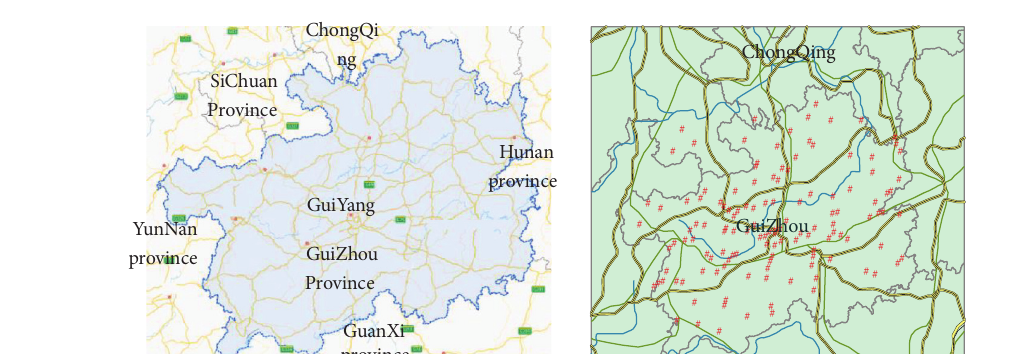
Figure 3: Positions of 347 highway toll stations of Guizhou province in China.